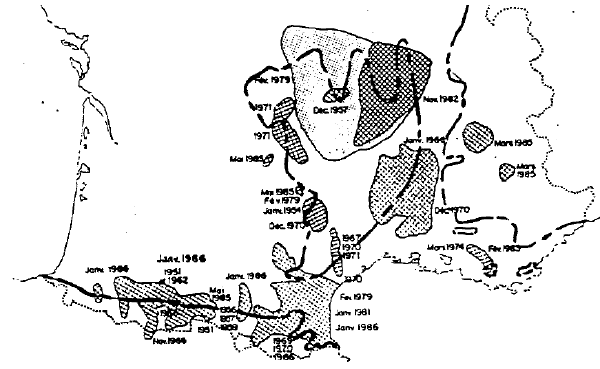
Figure 5. Areas concerned by wet-snow events before